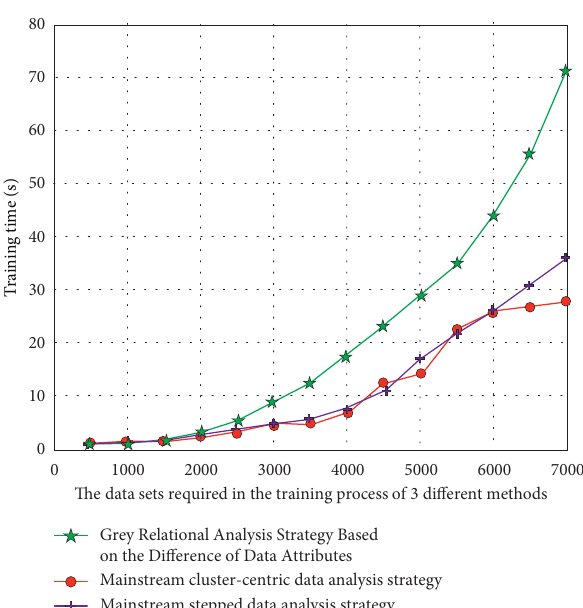
Figure 8: 3 different methods of learning and training time changes under different data